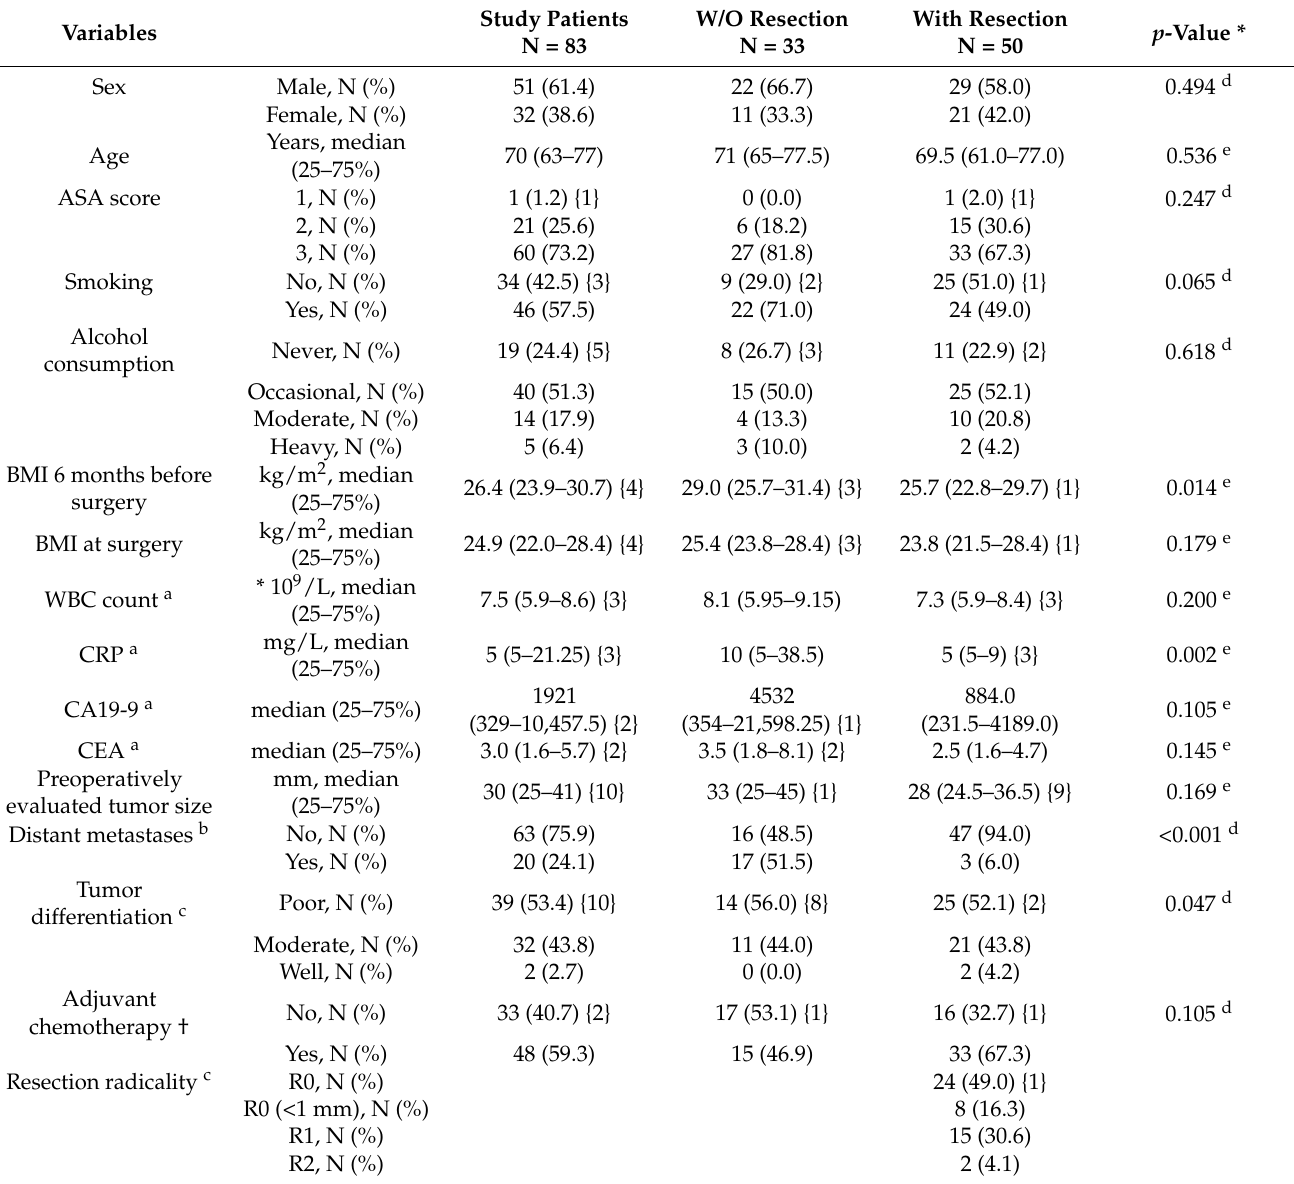
Table 1. Baseline patients’